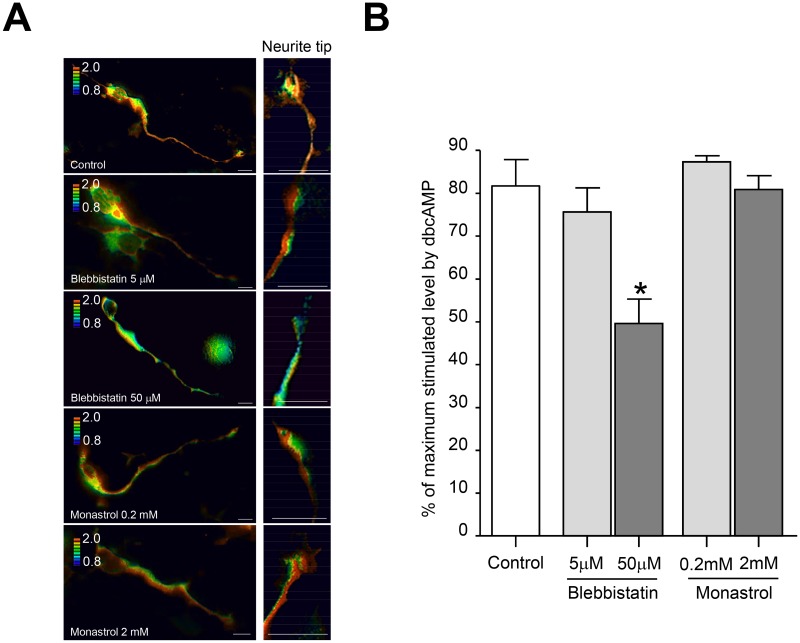
The PKA activity at the neurite tips was modulated by the local transport of GPR3 in CGNs.(A-B) Forty-five hours after transfection, GPR3-HT was labeled with the TMR HaloTag ligand for 15 min. After three sequential washes in PBS, the cells were incubated with Blebbistatin or Monastrol for another 2 hours. As a control, a 1:1000 dilution of DMSO was added to the culture medium. After capturing the CFP and FRET images, 1 mM dbcAMP was applied to the bath and additional CFP and FRET images were captured. (A) The representative FRET/CFP images from control, Blebbistatin-treated (5 μM, 50 μM), and Monastrol-treated (0.2 mM, 2 mM) CGNs at the neurite tips were shown. (B) The FRET/CFP ratio in each inhibitor-treated group were analyzed identically. The FRET/CFP ratios are expressed as the percentage of the maximum level stimulated by 1 mM dbcAMP in each cell. The data represent the means ± SEM for each condition (n = 8). The asterisk (*) represents p < 0.005.